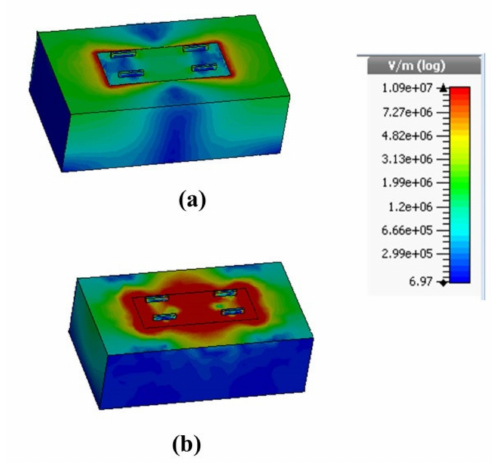
Figure 11. ( a ) Electric field magnitude distribution monitored at I Peak. i.e., f = 5.1 THz and ( b ) Electric field distribution monitored at II Peak. i.e., f = 11.7